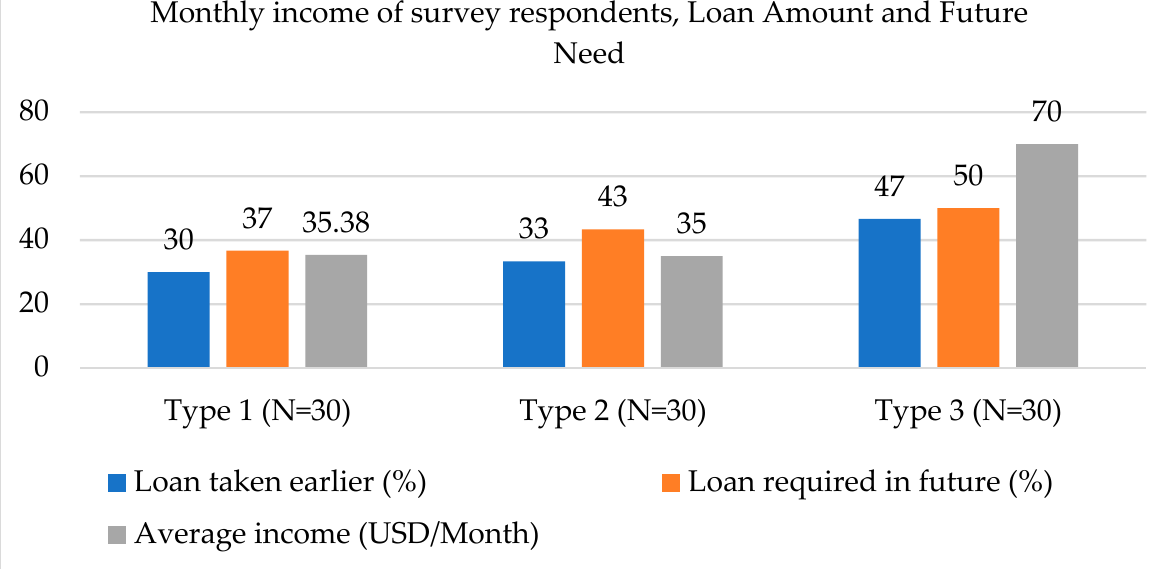
Figure 6. Status of average monthly income and loan taking by respondents in all three study areas.